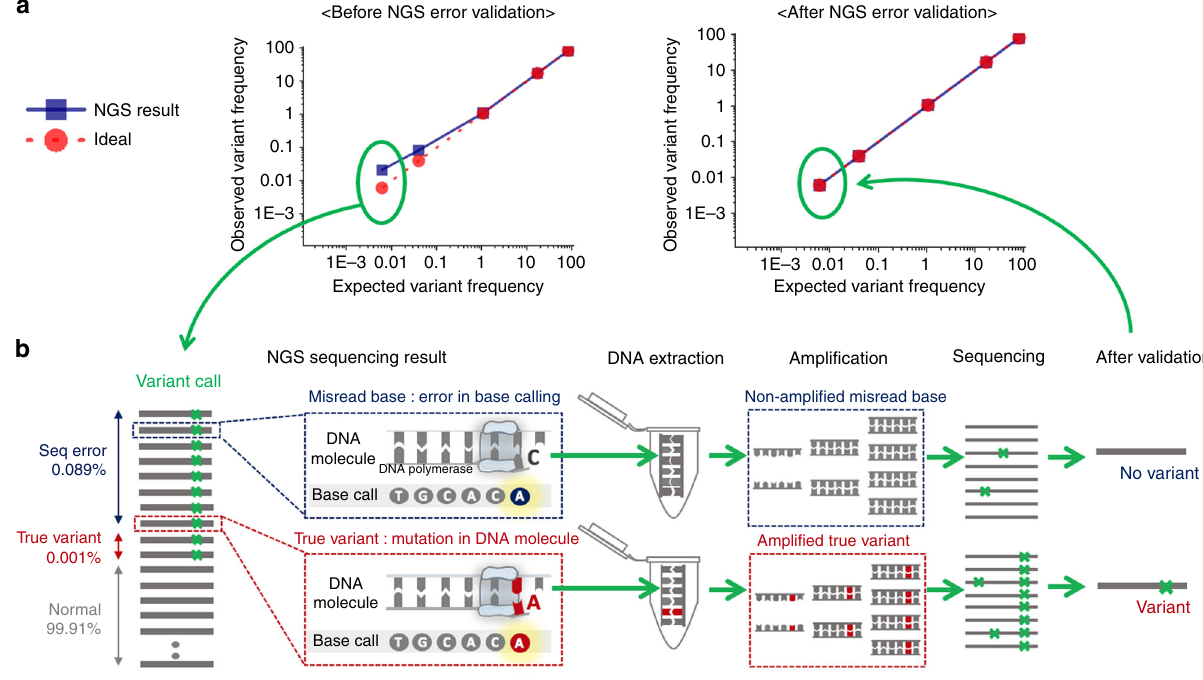
Fig. 1 The barcode-free NGS error validation method through the DNA clone isolation. a The difference of variant frequency (VF) observed before and after NGS error validation. In the NGS base calling system, ~1% of bases are incorrectly identi fi ed, which makes it hard to distinguish true variants at a frequency below 0.01%. b NGS error validation work fl ow. The erroneous reads of interest are selected, and their corresponding DNA clones are physically extracted from NGS substrate using LASER isolation. The obtained DNA clones are individually ampli fi ed by PCR, whereby only true variants can be duplicated. The ampli fi ed DNA clones are sequenced individually. (All data in this fi gure is based on the real data shown in Supplementary Figure 4.) Source data